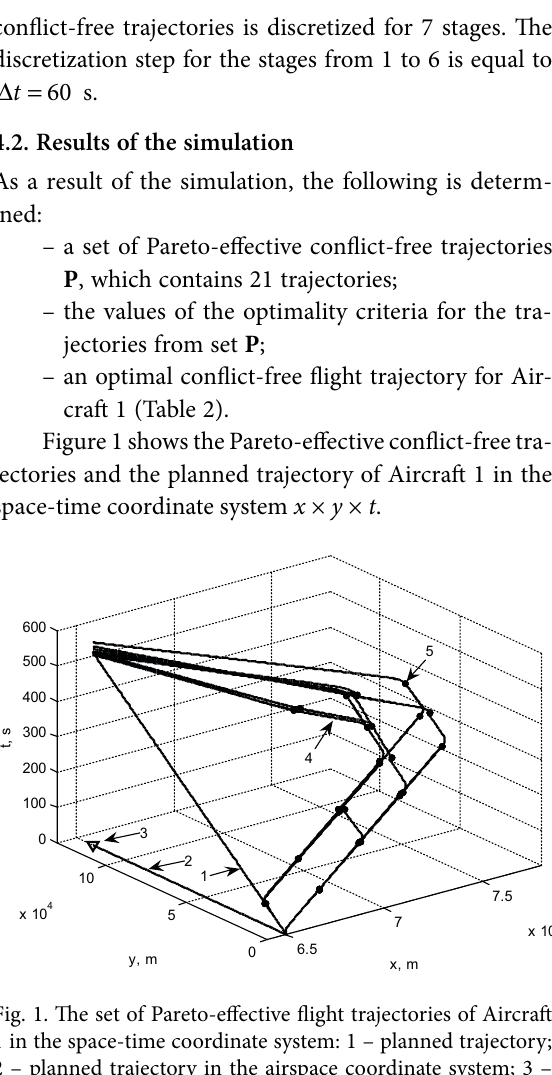
Fig. 1. The set of Pareto-effective flight trajectories of Aircraft 1 in the space-time coordinate system: 1 – planned trajectory; 2 – planned trajectory in the airspace coordinate system; 3 – check point on the route; 4 – Pareto-effective conflict free trajectories; 5 – states at different stages The set of Pareto-effective trajectories P is char- acterized by the following indices: the minimum and